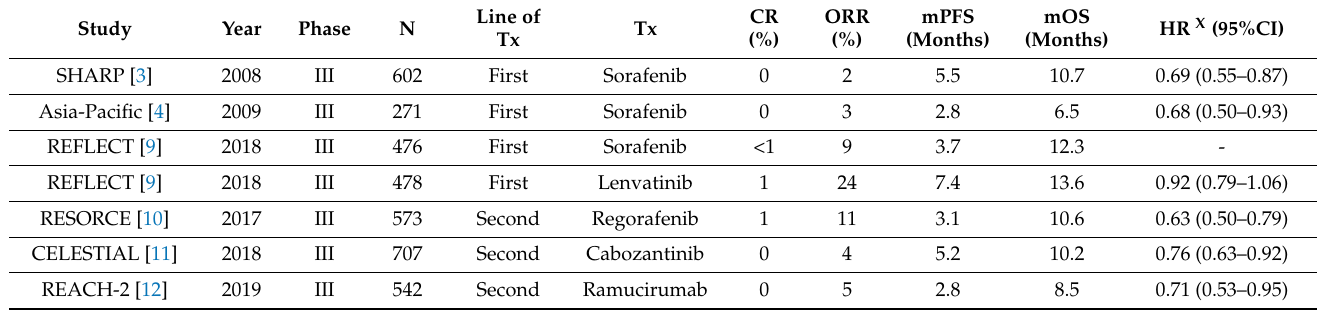
Table 1. Summary of main outcomes among systemic therapies (multi-kinase inhibitors) approved for advanced